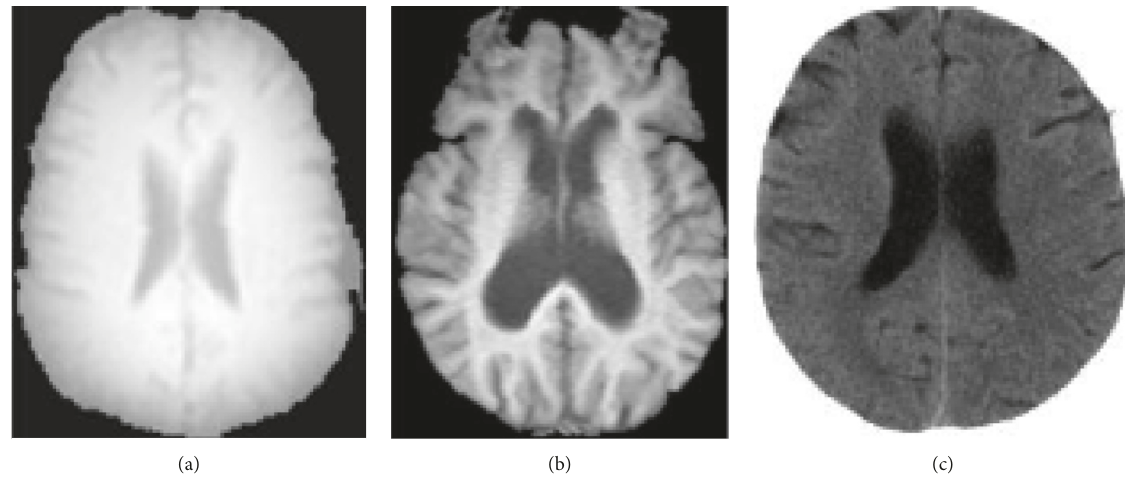
Figure 7: Examples from the ADNI database.